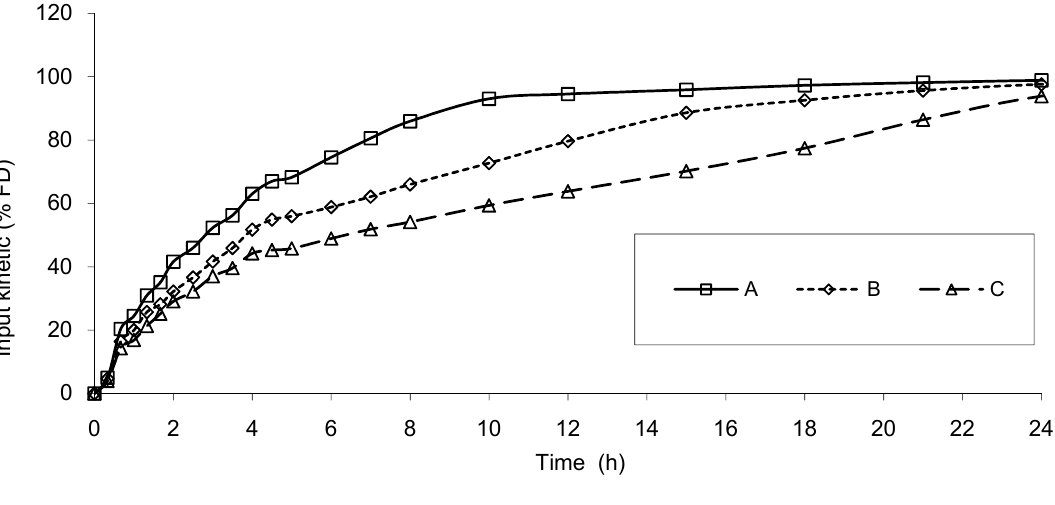
Figure 4. Input kinetics of Hydrocodone after administration of the 3 test tablet